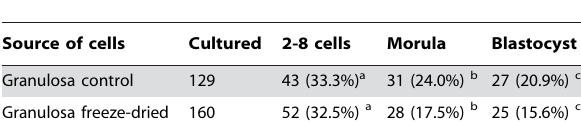
Table 1. In vitro development of enucleated oocytes injected with freeze-dried and fresh, control granulosa cells. Table 2. Total cell number and ICM and trophectoderm cell counting in control, and freeze dried cells-derived